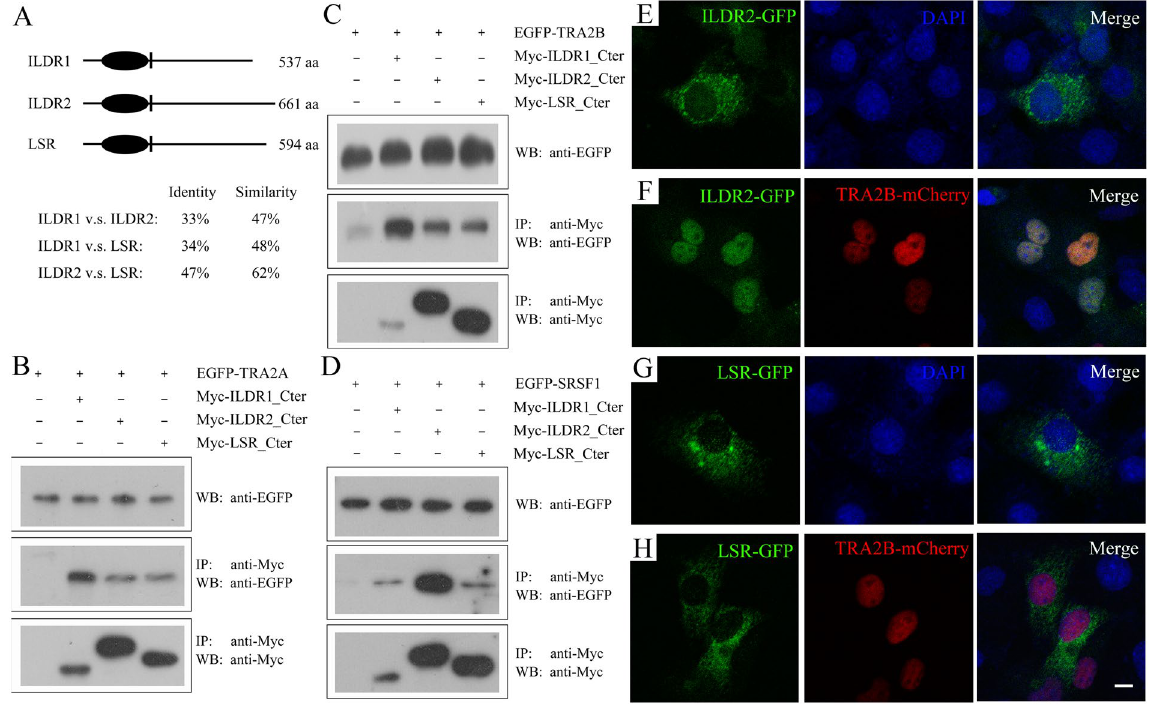
Figure 5. ILDR2 binds TRA2A/TRA2B/SRSF1. ( A ) Schematic drawing of the domain structures of Mus musculus ILDR1, ILDR2, and LSR. The identity and similarity between each other were indicated below. ( B ) Western blots showing that EGFP-tagged TRA2A was co-immunoprecipitated with Myc-tagged cytoplasmic fragment of ILDR1, ILDR2, or LSR. ( C ) Western blots showing that EGFP-tagged TRA2B was co-immunoprecipitated with Myc-tagged cytoplasmic fragment of ILDR1, ILDR2, or LSR. ( D ) Western blots showing that EGFP-tagged SRSF1 was co-immunoprecipitated with Myc-tagged cytoplasmic fragment of ILDR1, ILDR2, or LSR. Expression vectors were transfected into HEK293T cells to express epitope-tagged proteins, and cell lysis were subject to immunoprecipitation. 5% of total protein was loaded as input. IP indicates antibody used for immunoprecipitation and WB indicates antibody used for detection. Uncropped blots are shown in Fig. S10. ILDR2-GFP ( E ) and LSR-GFP ( G ) localize in the cytoplasm. However, when TRA2B-mCherry